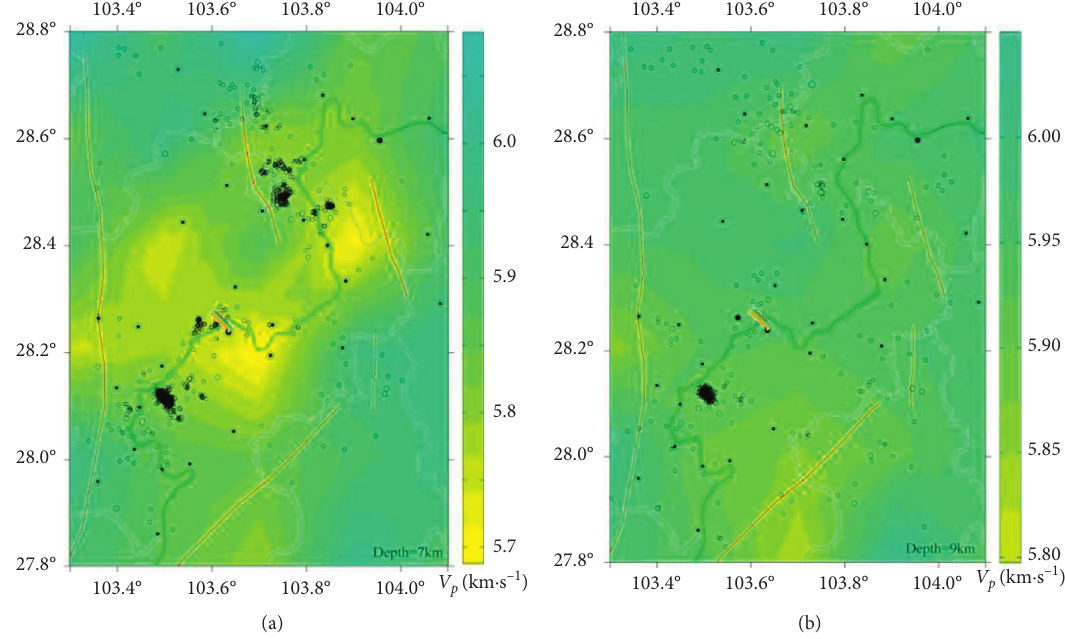
Figure 7: Inversion results based on crustal P -wave velocity (a) at 7km depth (depth of small earthquake: 6.0–7.9km); (b) at 9 km depth (depth of small earthquake ≥